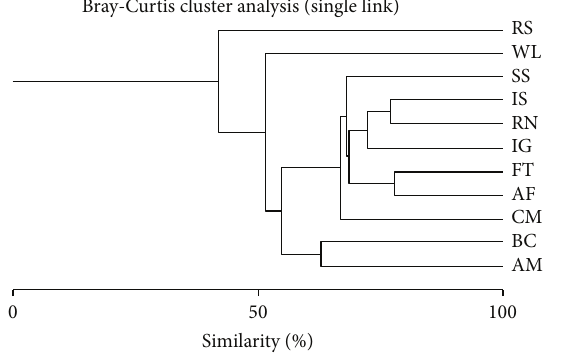
Figure 11: Species composition-based microlandscape clusters